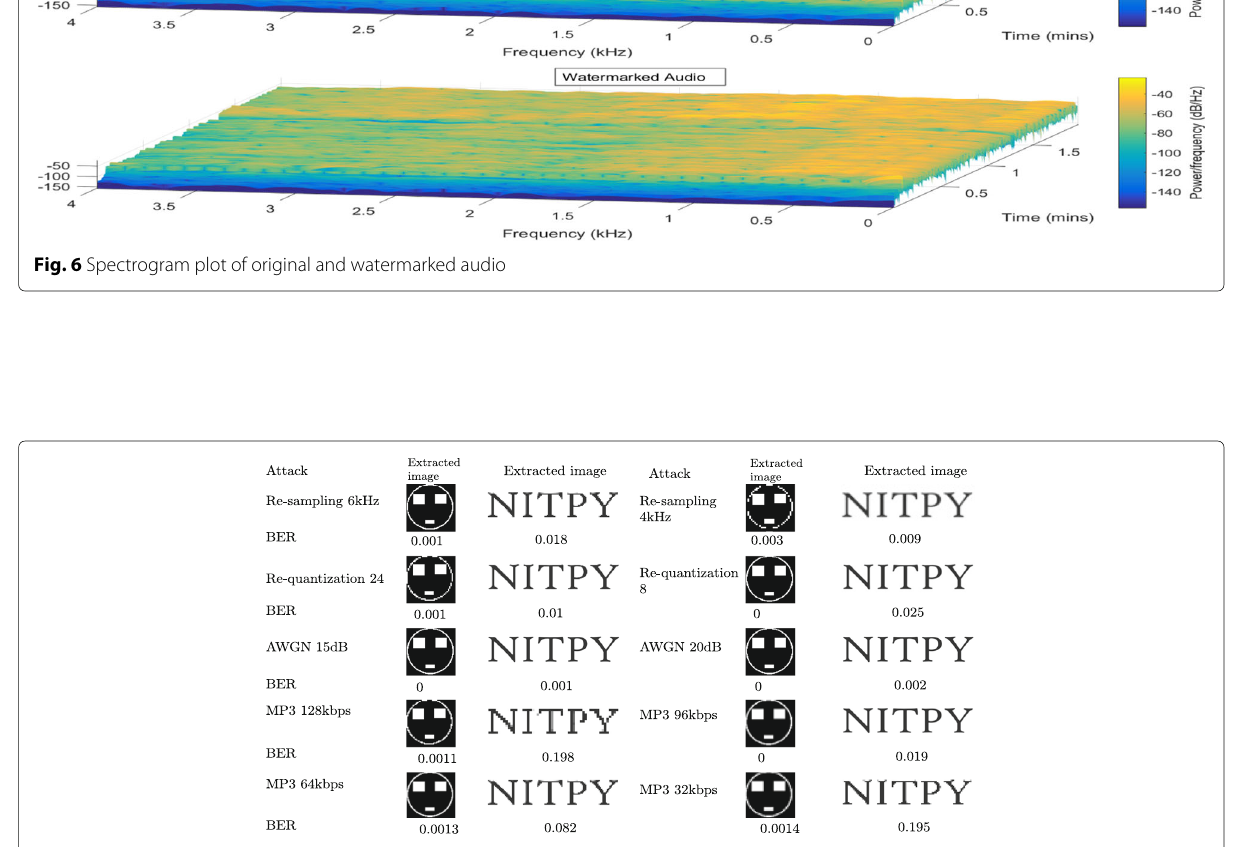
Fig. 7 Extracted watermark images with BER for speech audio signal for re-sampling, re-quantization, AWGN, and MP3 compression attacks